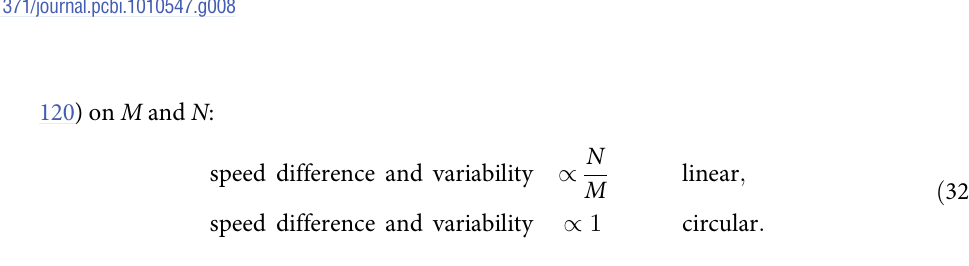
Fig 8. Bump speed irregularity due to connectivity noise at high drive. ( A ) Bump speed as a function of bump position with connectivity noise of magnitude 0.002 and drive b = 1.5. Network with 600 neurons, 1 bump, and the same realization of connectivity noise as in Fig 7A– 7C. Thick gray lines indicate Eq 25. ( B – E ) Networks with multiple realizations of connectivity noise of magnitude 0.002 and drive b = 1.5. ( B ) Speed difference between directions decreases with bump number under linear mapping and remains largely constant under circular mapping. Networks with 600 neurons. ( C ) Speed difference increases with network size under linear mapping and remains largely constant under circular mapping. Networks with 3 bumps. ( D and E ) Same as B and C , but for speed variability within each direction. Points indicate simulation means over 48 realizations and bars indicate standard deviations. Dotted gray lines indicate Eqs 30 and 31 averaged over 96 realizations.